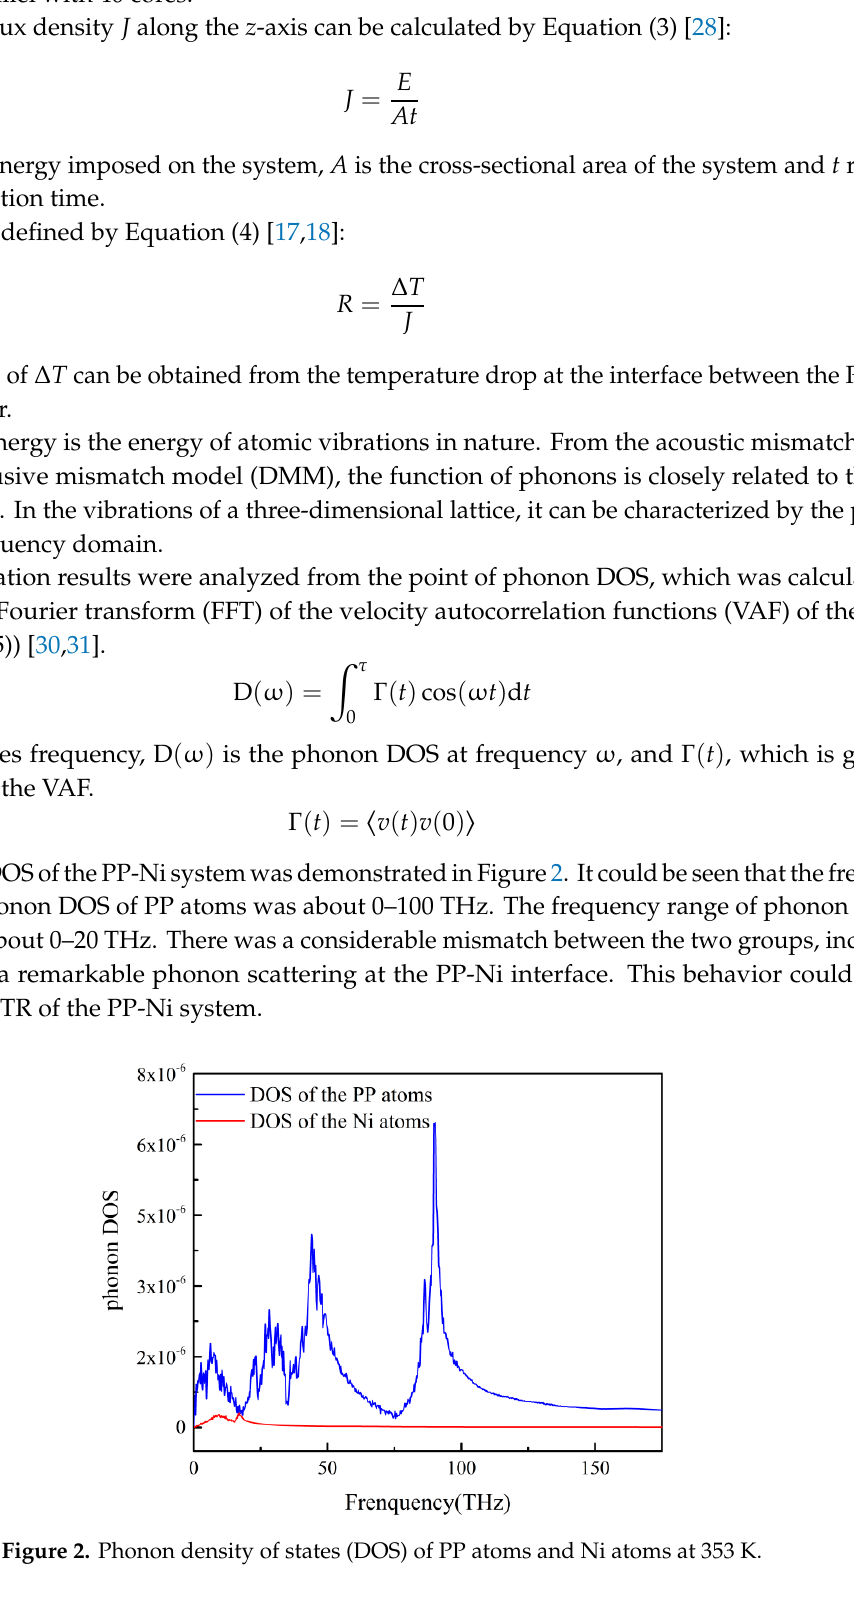
Figure 2. Phonon density of states (DOS) of PP atoms and Ni atoms at 353 K.